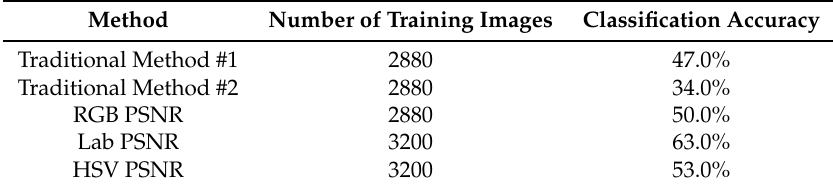
Table 1. Classification accuracies of traditional methods and methods that use the inverse PSNR.